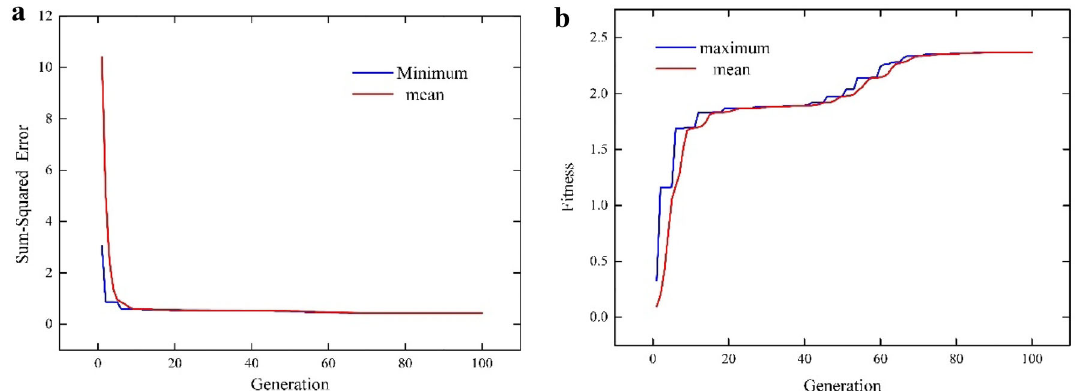
Fig. 4 Sum-squared error and fitness-function